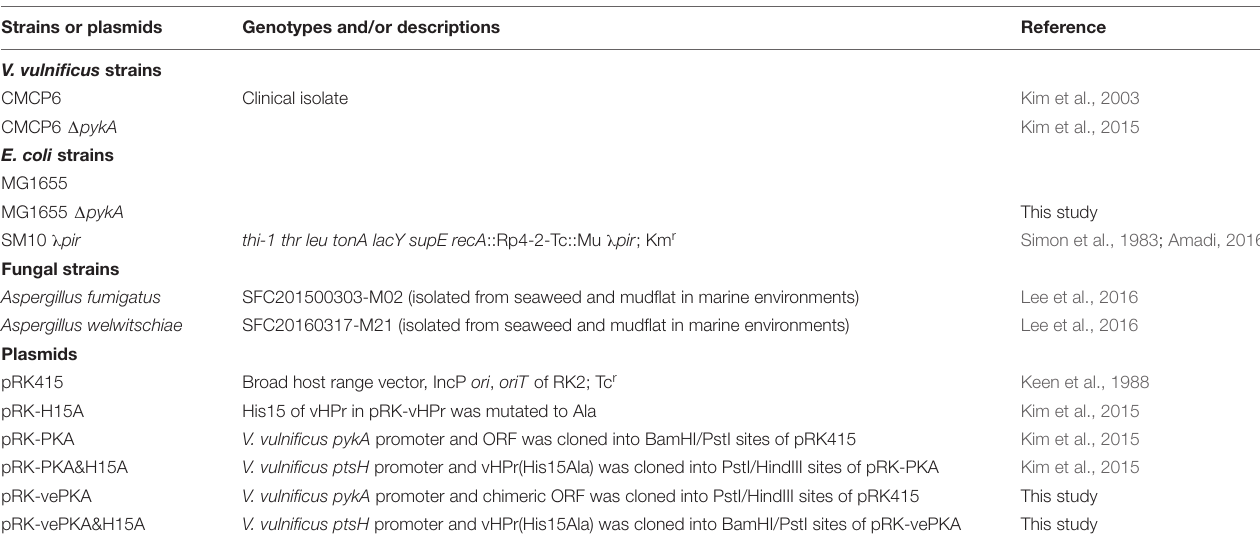
TABLE 1 | Bacterial and fungal strains and plasmids used in this